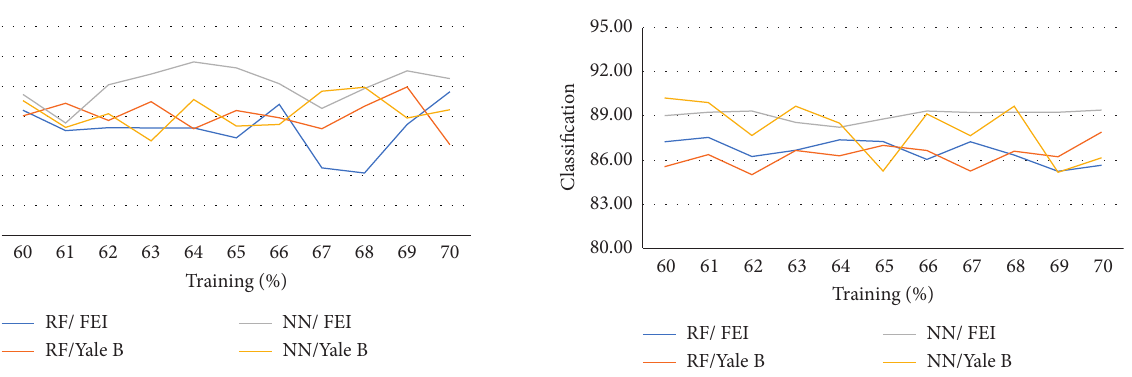
Figure 14: The classification results of the FLBP method using 60% to 70% of the training data (FEI and Yale B datasets) and the classification performance of NN and